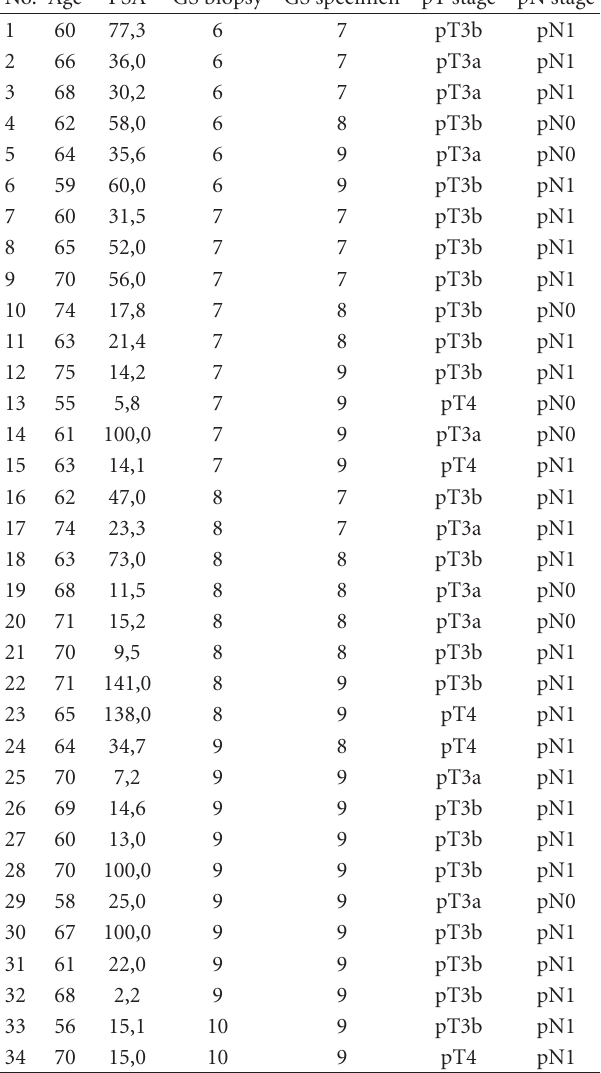
Table 1: Characteristics of patients with locally advanced prostate